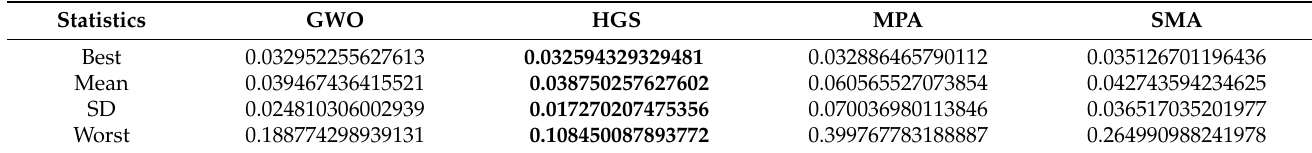
Table 7. Experimental result of RMSE with 80 individuals, 40 evolutions and 30 repetitions.